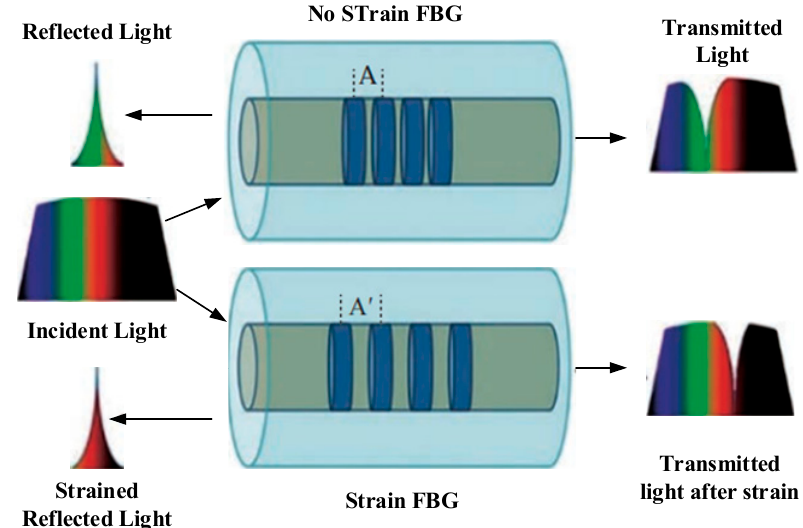
Figure 3. Schematic diagram of working principle of fiber Bragg grating sensor and its strain re- sponse.